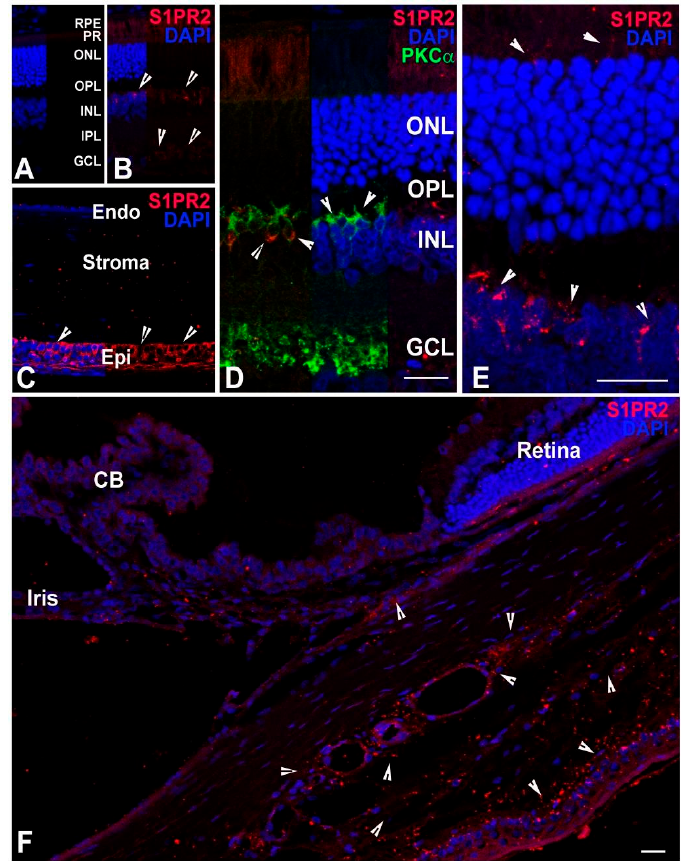
Figure 5. Localization of S1PR2 in adult (2–7 months old) rat ocular tissues. S1PR2 localization (red) was detected by anti-S1PR2 antibodies. ( A ) Rat retinal section in which the anti-S1PR2 antibodies were replaced with normal goat serum. The layers were marked and served as a negative control. ( B ) Retinal section of SD rat eye and S1PR2 localization in different layers is shown by arrowheads. ( C ) Corneal section of SD rat eye and S1PR2 localization in different layers is shown by arrowheads. ( D ) Magnified view of SD rat retinal section and S1PR2 localization with respect to PKC α in the INL and OPL layer, which is shown by arrowheads. ( E ) Magnified view of SD rat retinal section with emphasis on inner nuclear layer (INL) localization of S1PR2 shown by arrowheads. ( F ) Partial anterior segment of SD rat eye containing ciliary epithelial cells, Trabecular meshwork and Schlemm’s canal. S1PR2 localization is shown by arrowheads. CB, ciliary body. RPE, retinal pigment epithelium. PR, photoreceptor. ONL, outer nuclear layer. OPL, outer plexiform layer. INL, inner nuclear layer. IPL, inner plexiform layer. GCL, ganglion cell layer. Endo, endothelium. Epi, epithelium. Scale = 25 µm.